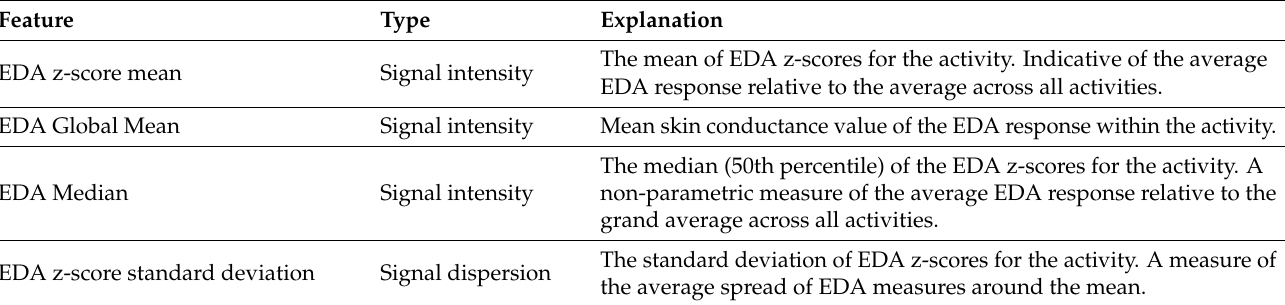
Table 1. Features extracted from the EDA